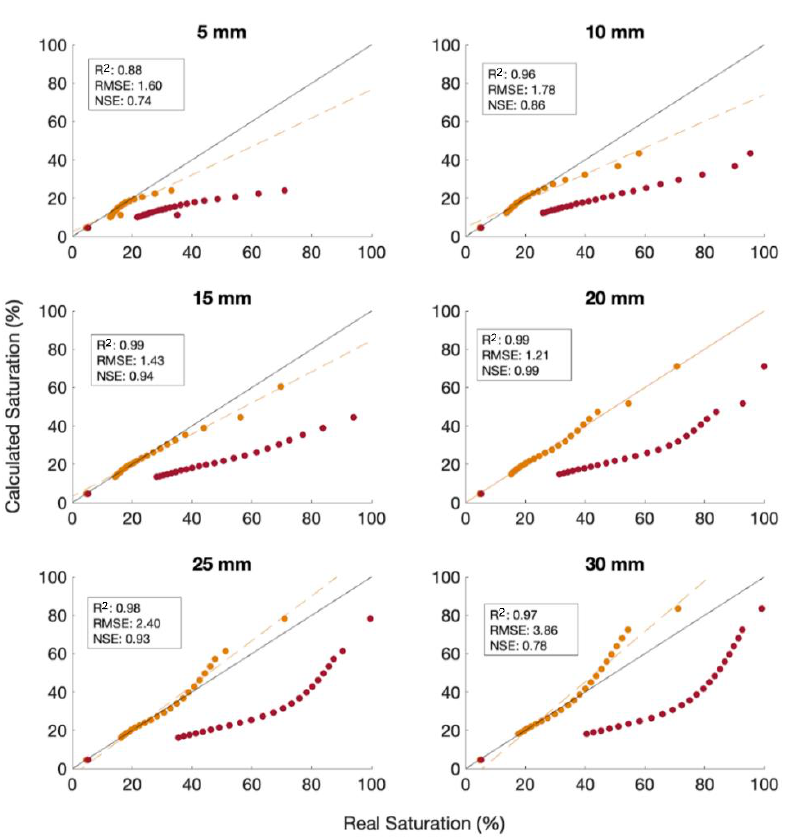
Figure 6. Simulation results using the 2 min-20 mm/hr calibration with recharge from 5 mm/hr to 30 mm/hr (orange). The results using the 2-min flow calibration (red) are displayed as reference.